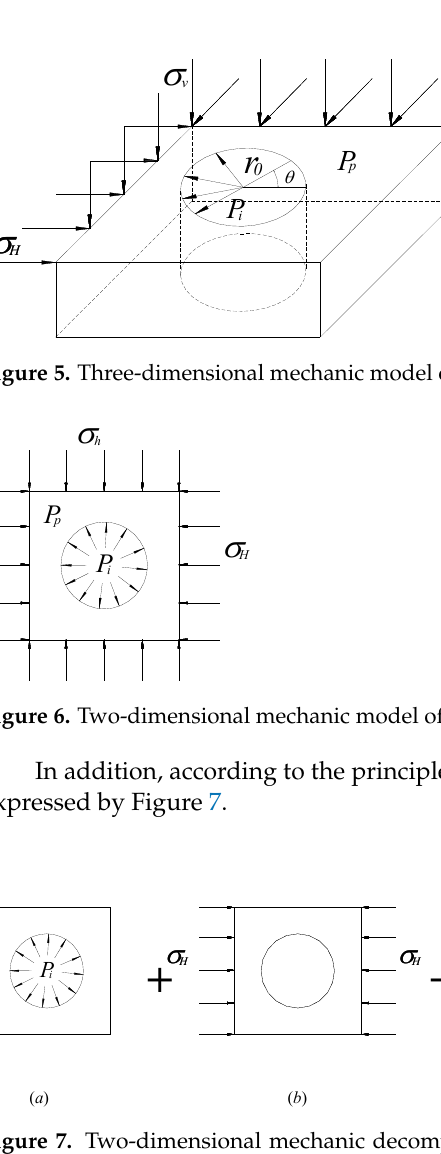
Figure 7. Two-dimensional mechanic decomposition model of shaft wall rock: ( a ) drilling fluid pressure; ( b ) major horizontal stratum stress; ( c ) minor horizontal stratum